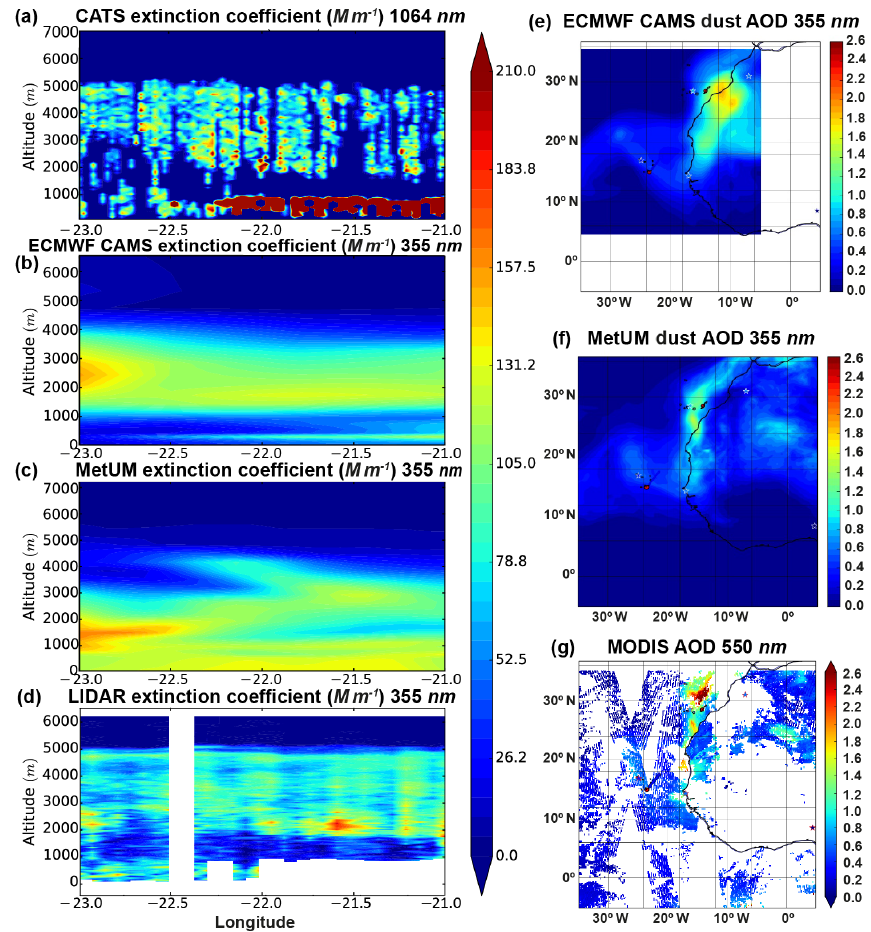
Figure 3. Case study 1, B920, 7 August, R6: (a–d) vertical cross section along the flight track showing the aerosol extinction coefficient for the CATS lidar (a) , ECMWF–CAMS (b) , MetUM (c) , and the aircraft lidar (d) ; the colour scale is the same for all four plots. (e) ECMWF AOD map, (f) MetUM AOD map, and (g) AOD map from combined observations from MODIS, AERONET (stars), and aircraft lidar